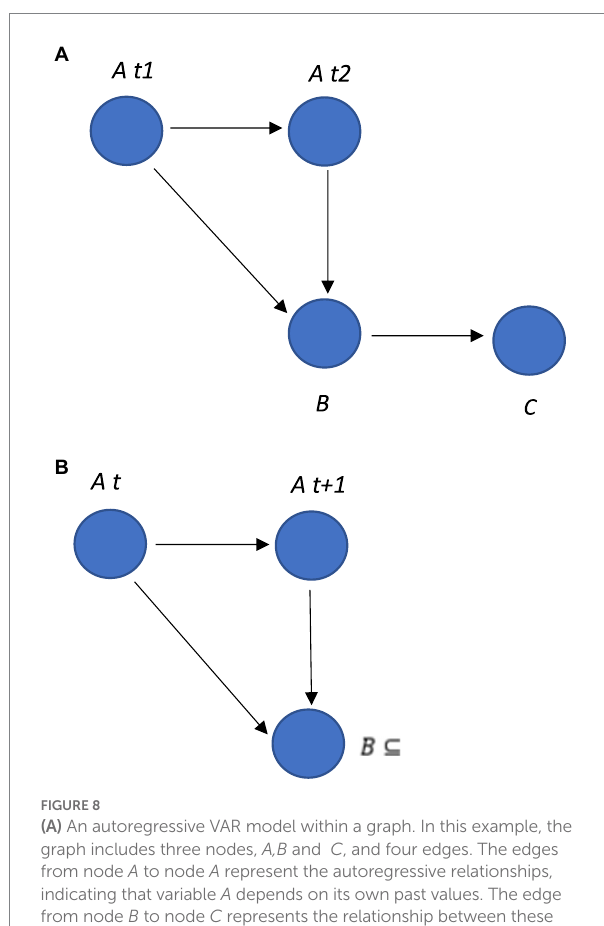
FIGURE 8 (A) An autoregressive VAR model within a graph. In this example, the graph includes three nodes, A,B and C , and four edges. The edges from node A to node A represent the autoregressive relationships, indicating that variable A depends on its own past values. The edge from node B to node C represents the relationship between these variables, indicating that B depends on C . (B) The edge from node B at time t + 1 to node A could be described as ( A t which is interpreted as saying that the value of B at time t + 1 is a subset of the value of A at time t